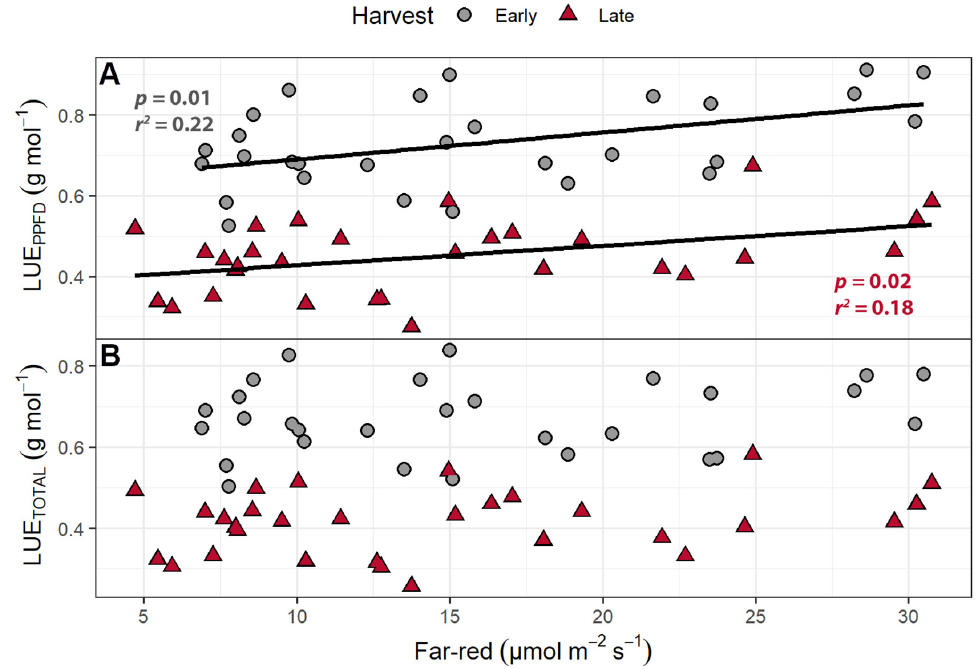
Figure 10. ( A ) The effect of supplemental far-red light on light use efficiency calculated based on photosynthetic photon flux density (PPFD) (LUE PPFD ) and ( B ) total photon flux density (LUE TOTAL ) of “Green Salad Bowl” lettuce ( Lactuca sativa ). Plants were grown under a PPFD ranging from 111 to 245 µmol m − 2 s − 1 with a perpendicular far-red light gradient ranging from 4.7 to 32.8 µmol m − 2 s − 1 . The LUE PPFD and LUE TOTAL were calculated by dividing the shoot dry weight by the cumulative incident light from 400 to 700 nm or 400 to 800 nm, respectively, to determine how effectively plants used incident light to produce biomass. The early harvest occurred 16 days after germination, while the late harvest occurred 25 days after germination.